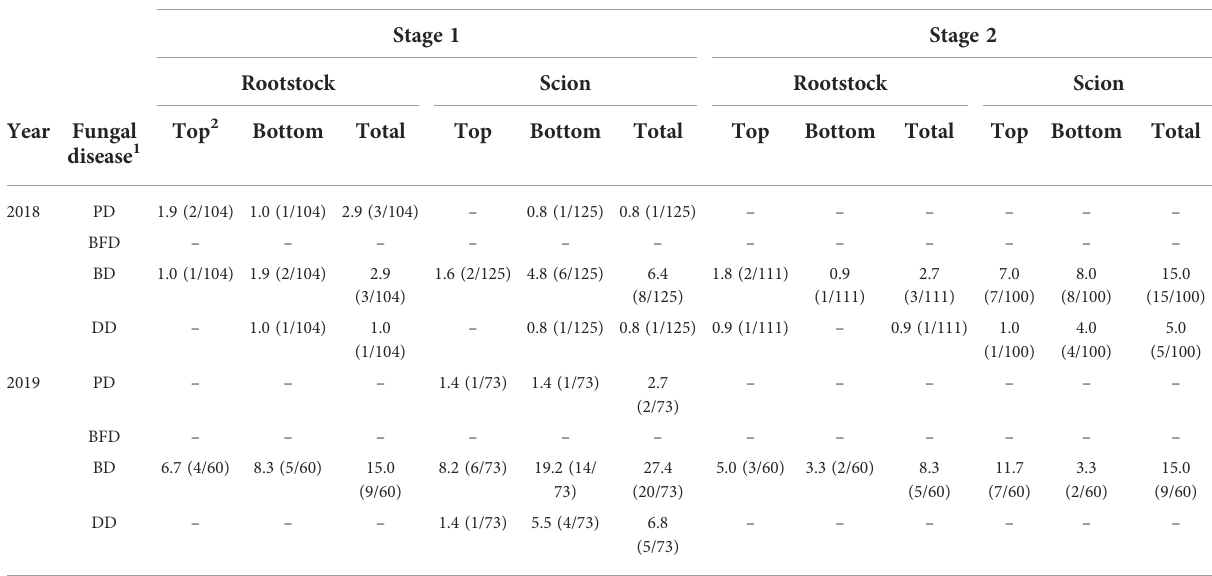
TABLE 2 Incidence of fungal grapevine trunk diseases in rootstock and scion cuttings from mother plants (stage 1) and rootstock and scion cuttings after cold storage and hydration (stage